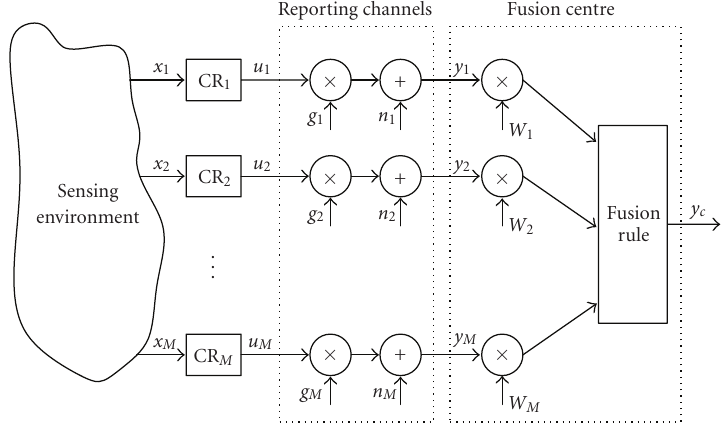
Figure 13: Schematic diagram of weighted collaboration at fusion centre for soft decision combining with imperfect reporting